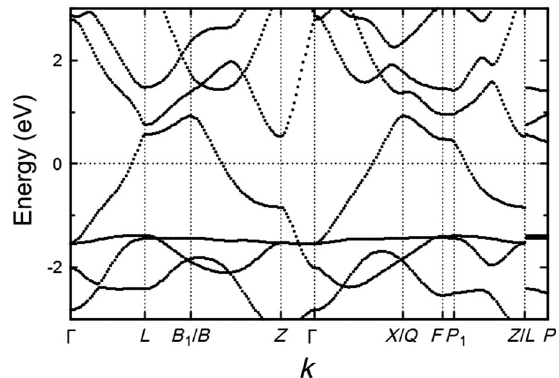
FIG. 9. Calculated band structure of Sr 2 N.